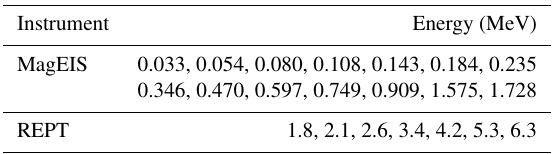
Table 1. MagEIS and REPT energy channels used in this study. Instrument Energy